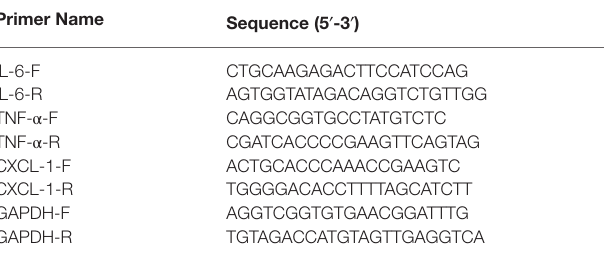
TABLE 1 | Mouse primers used for